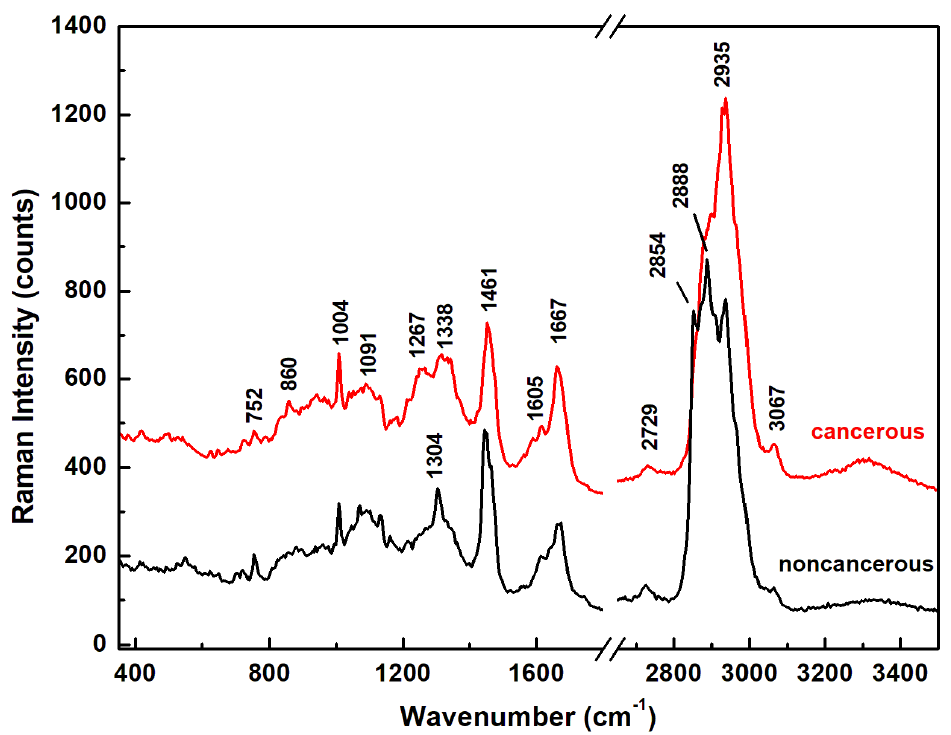
Figure 1. Integrated Raman spectra of normal control sample (black spectrum) and GBM cancer control sample (red spectrum).